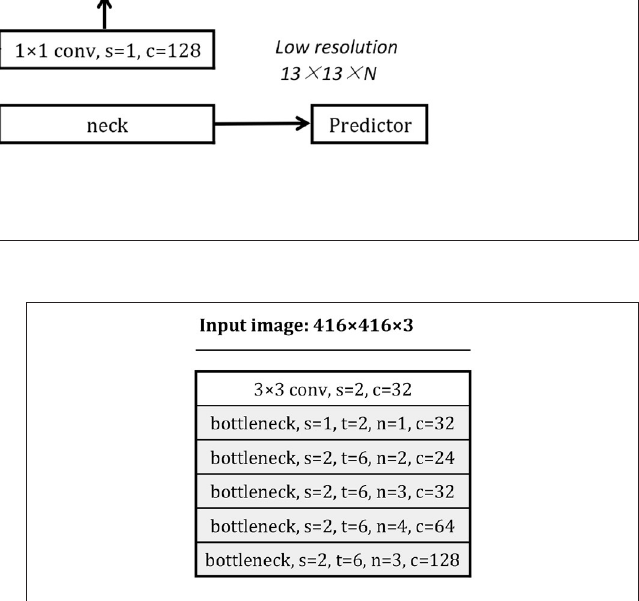
FIGURE 6 | The compact MobileNet v2